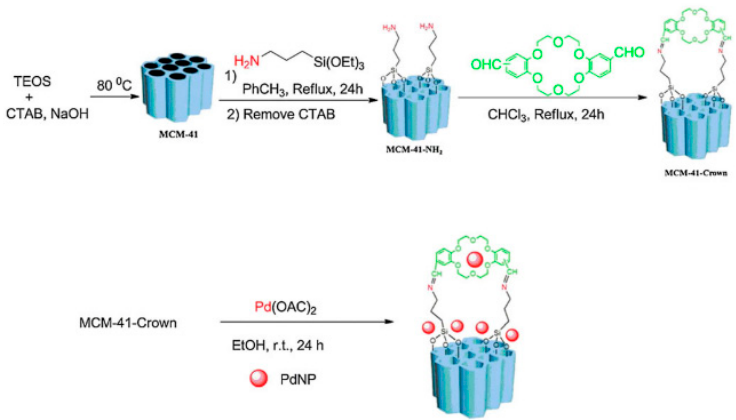
Figure 46. Synthetic route for preparation of MCM-41-Crown.Pd. Reproduced with permission from